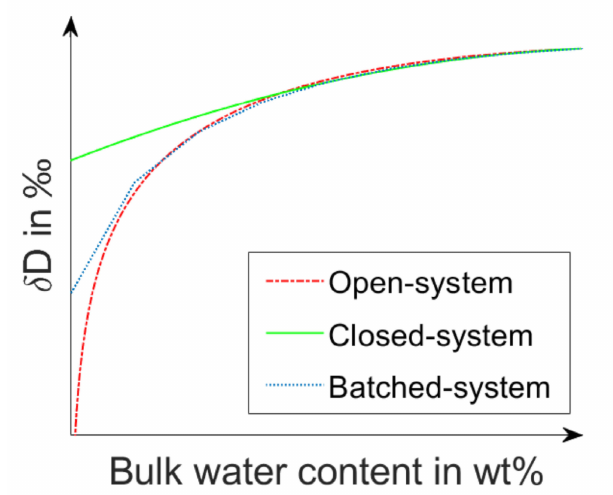
Figure 1: Qualitative trends of hydrogen isotope frac- tionation occurring during di ff erent degassing